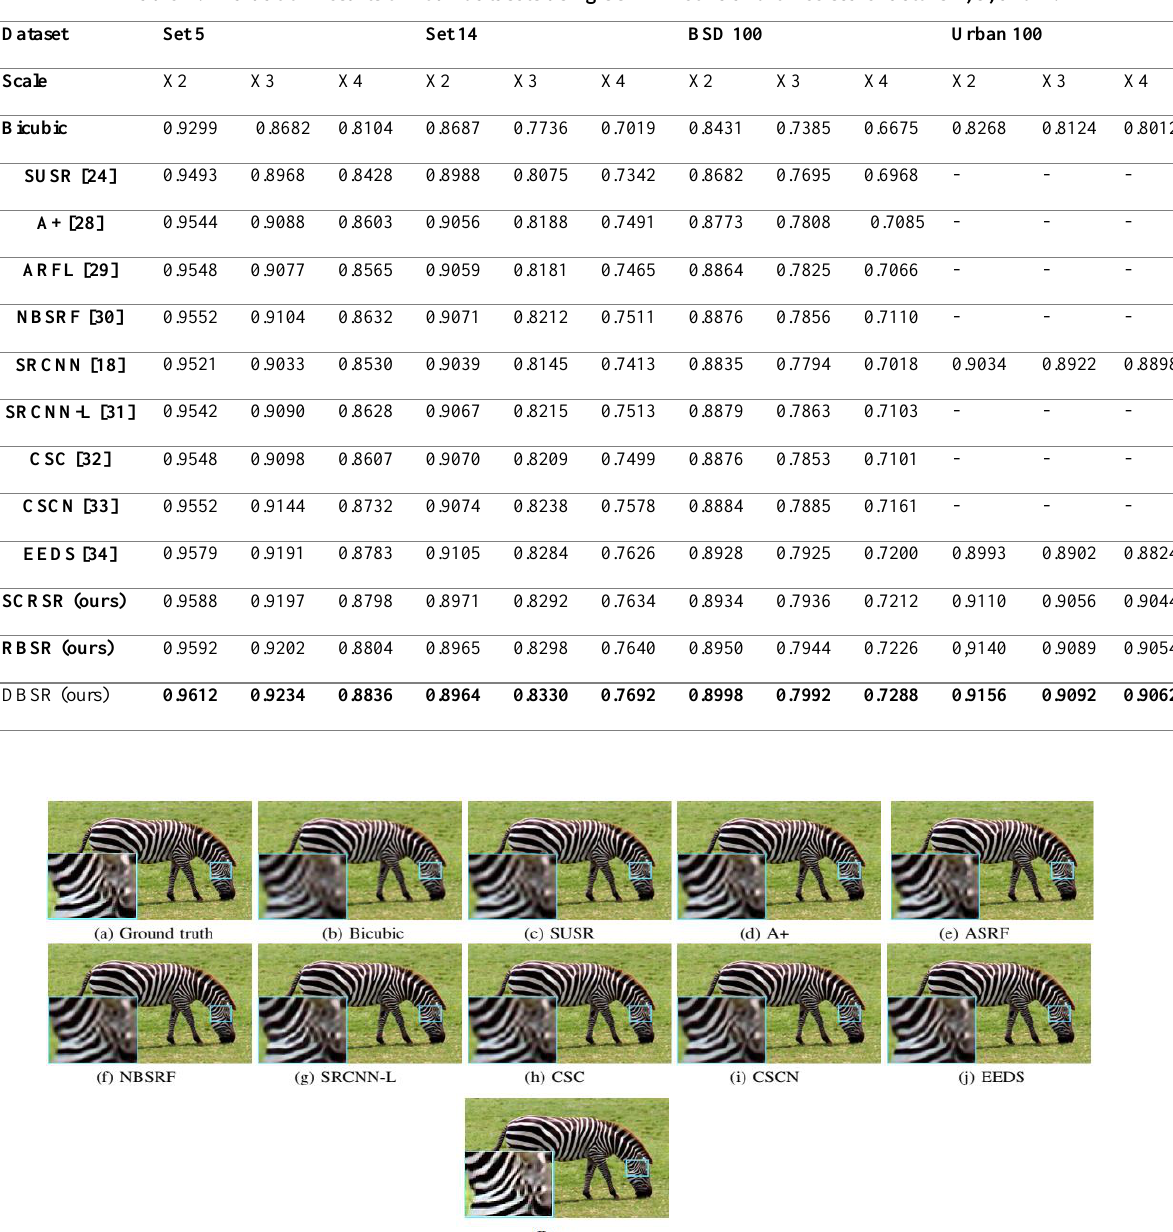
Table 4. Evaluation results on four datasets using SSIM metric and three scale factors 2, 3, and 4.